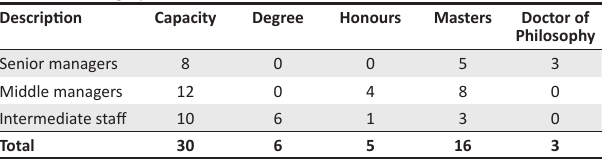
TABLE 1 : Demographic